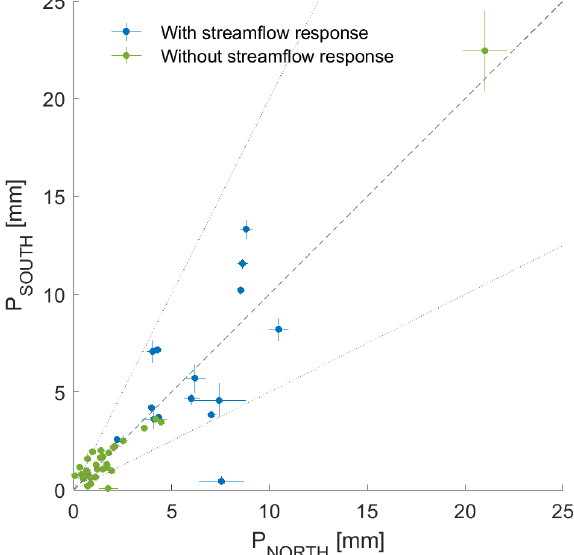
Figure 5. Scatterplot of the rainfall amounts over the northern and the southern parts of the catchment for all 48 rainfall events. The dotted lines show the one over two and two over one lines which correspond to 2 times more rainfall in one part of the catchment than in the other or to | I ASYM | > 0 . 33. The highest event is an outlier (event of 6 August, with 43.5mm of rainfall in total) and is flagged without streamflow response because the river stage measure was disturbed during this